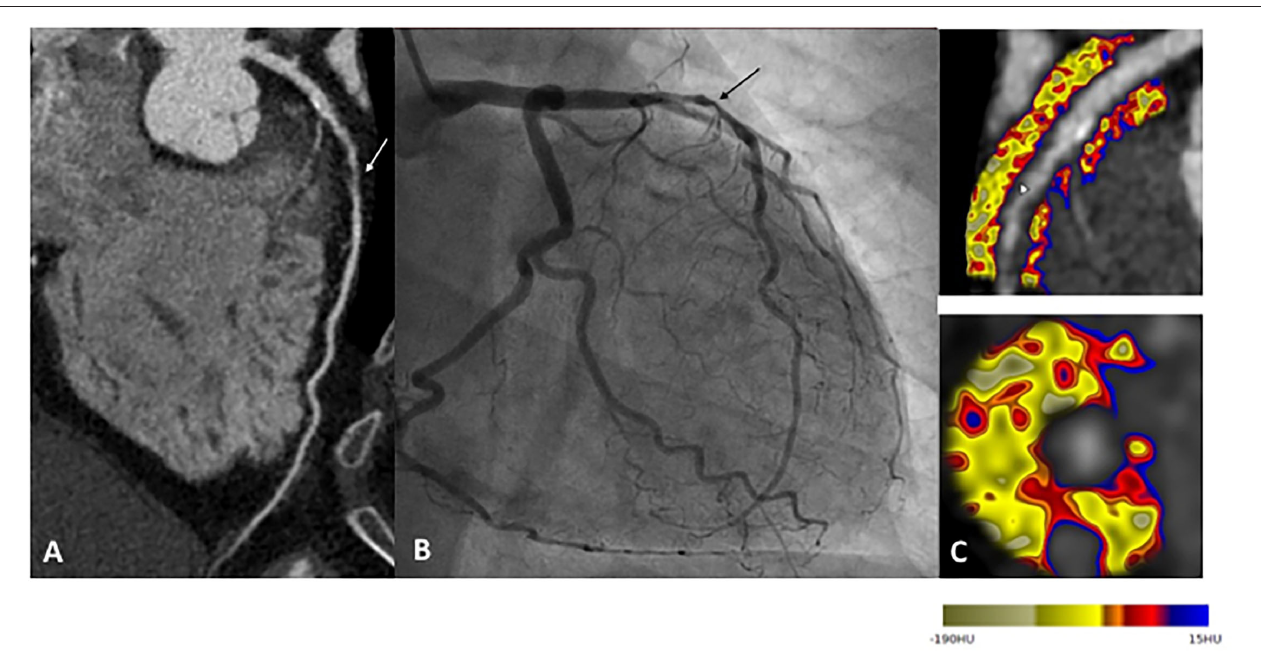
FIGURE 1 | Example of a patient reporting exertional dyspnea. In (A) , CTCA showed significant CAD on left anterior descending (LAD) artery (white arrow), classified CAD-RADS 4A. Coronary angiogram confirm severe stenosis of proximal LAD (black arrow), angioplasty followed by stenting was performed to relieve symptoms (B) . Finally, CTCA post-treatment based on the FAI-Score values (C) on three arteries, the coronary atherosclerotic plaque burden and the clinical risk factors showed low CaRi-Heart Risk, thereby predicting low risk of future acute coronary events and permitted treatment goals and follow-up strategies